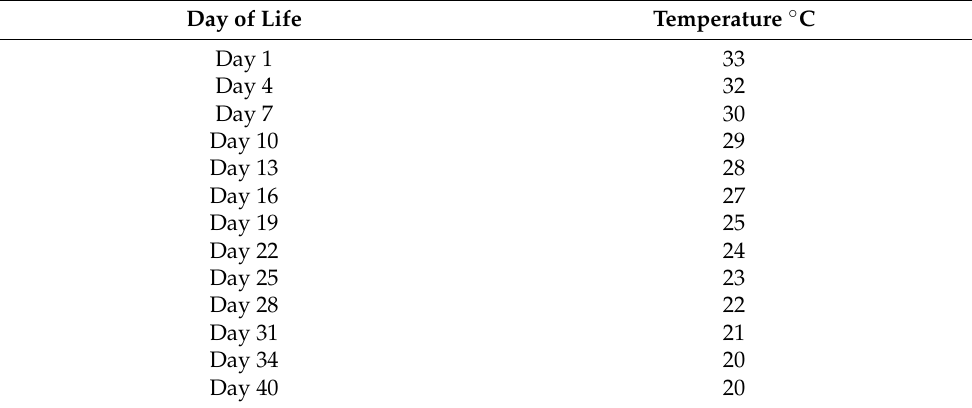
Table 1. Optimal temperatures at which the animals were housed at different days of life during the in vivo trial.